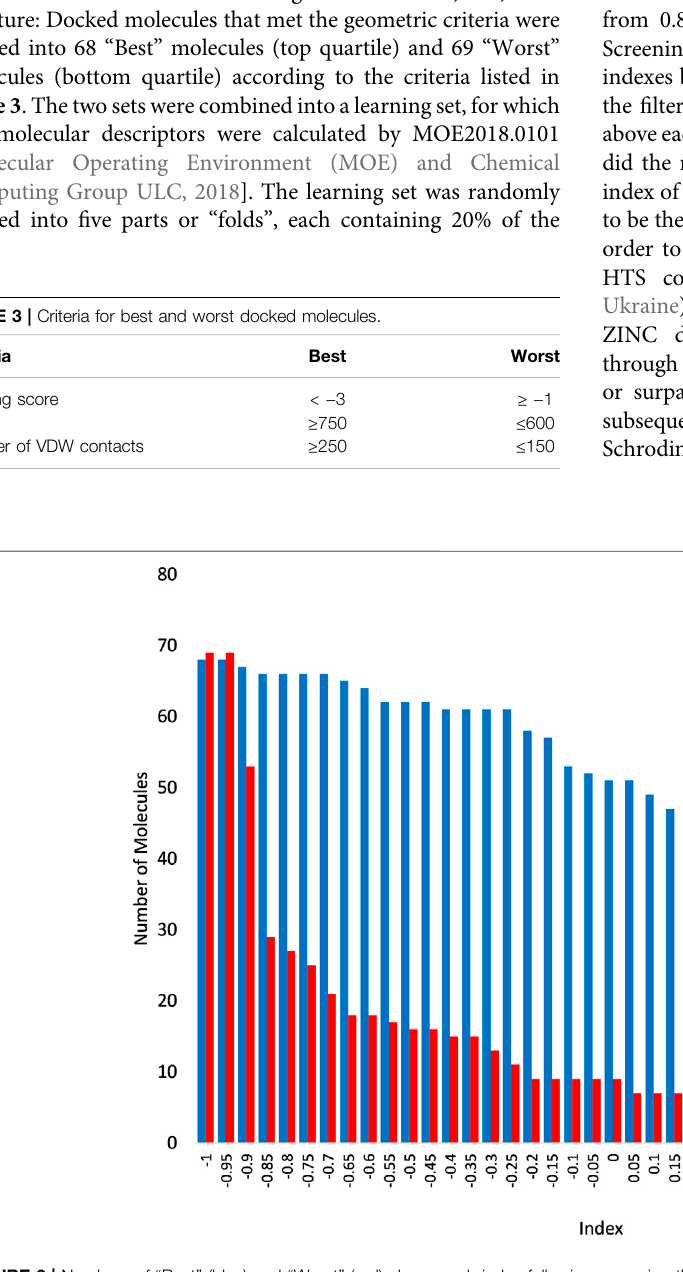
FIGURE 3 | Numbers of “ Best ” (blue) and “ Worst ” (red) above each index following screening through the ISE model. As the index increases, the number of molecules decreases in both the “ Best ” and “ Worst ” molecular sets, but at a much slower rate for the former than the latter, and so the remaining set is increasingly enriched with “ Best ”